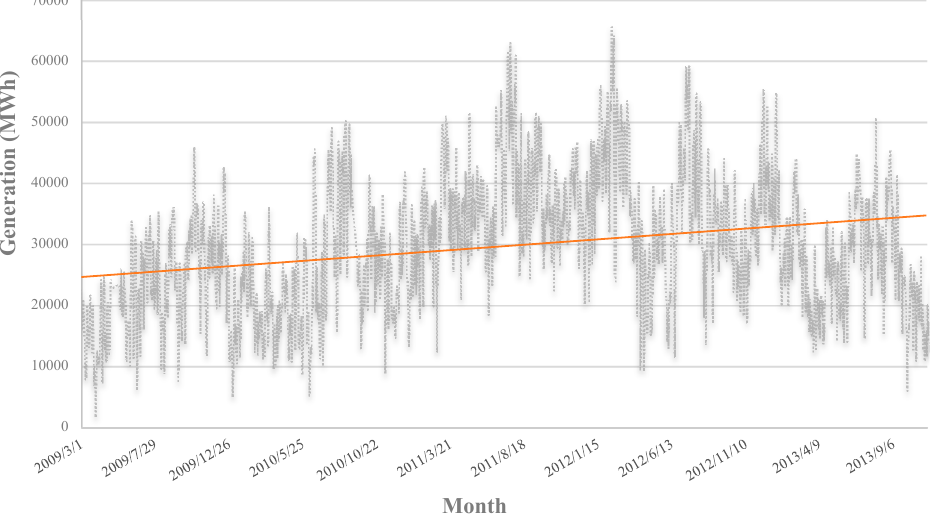
Figure 8. Daily generation from natural gas-fueled plants in Greece during the period March 2009 to November 2013 (data as acquired from [48]).